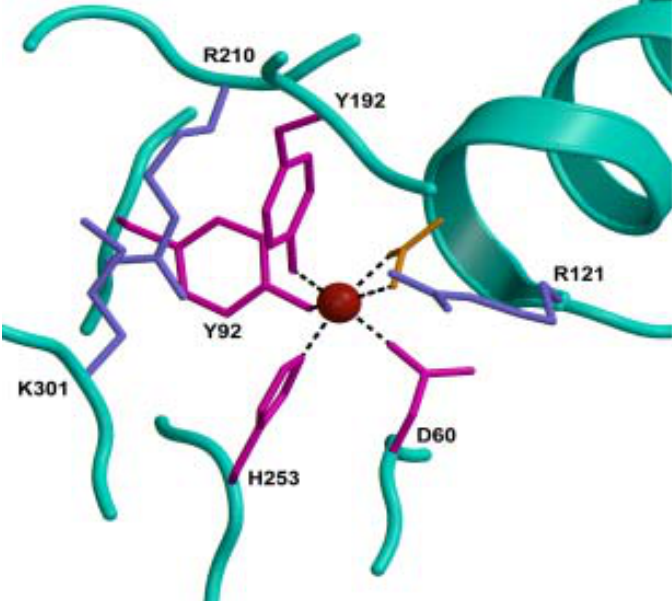
Figure 2. Iron binding site in the N-lobe of lactoferrin. From Baker and Baker